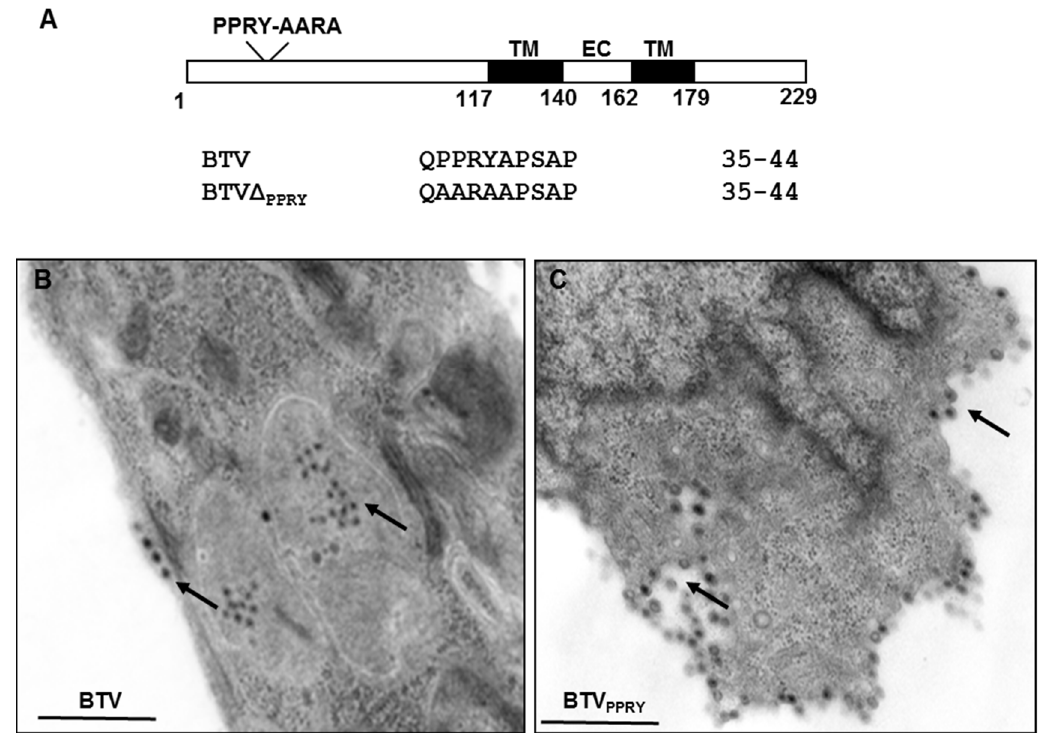
Figure 5. Mutation of PPXY late domain in NS3. ( A ) Schematic representation depicting position of the PPRY motif in NS3. The numbers designate amino acid positions in NS3 sequence; TM and EC signifies transmembrane domain and extra cellular regions ( B , C ). Electron Microscope analysis of PT cell sections infected with WT BTV ( B ) and BTV Δ ( C ) analyzed at 20 h pi. Virus particles under the plasma membrane and within vesicles (black arrows) been indicated. Bar, 500